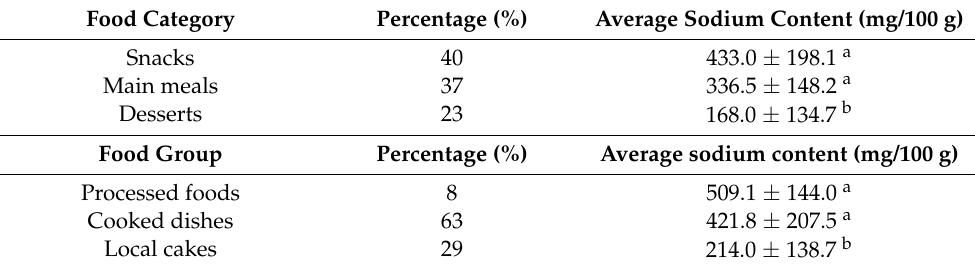
Table 2. The average sodium content in different street food categories and groups.